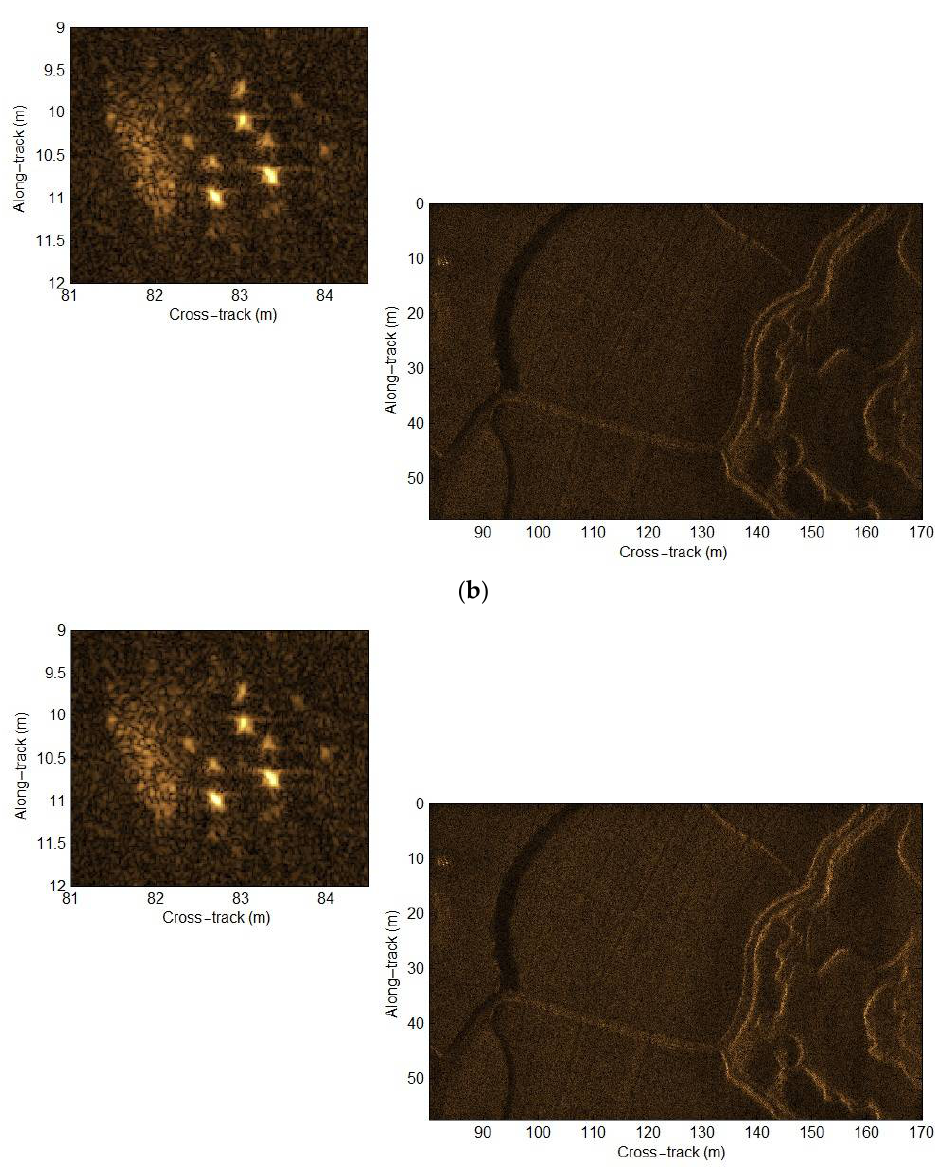
Figure 18. Real data processing results with the case of a narrow-bandwidth signal. ( a ) Traditional method; ( b ) presented method; ( c ) BP algorithm.